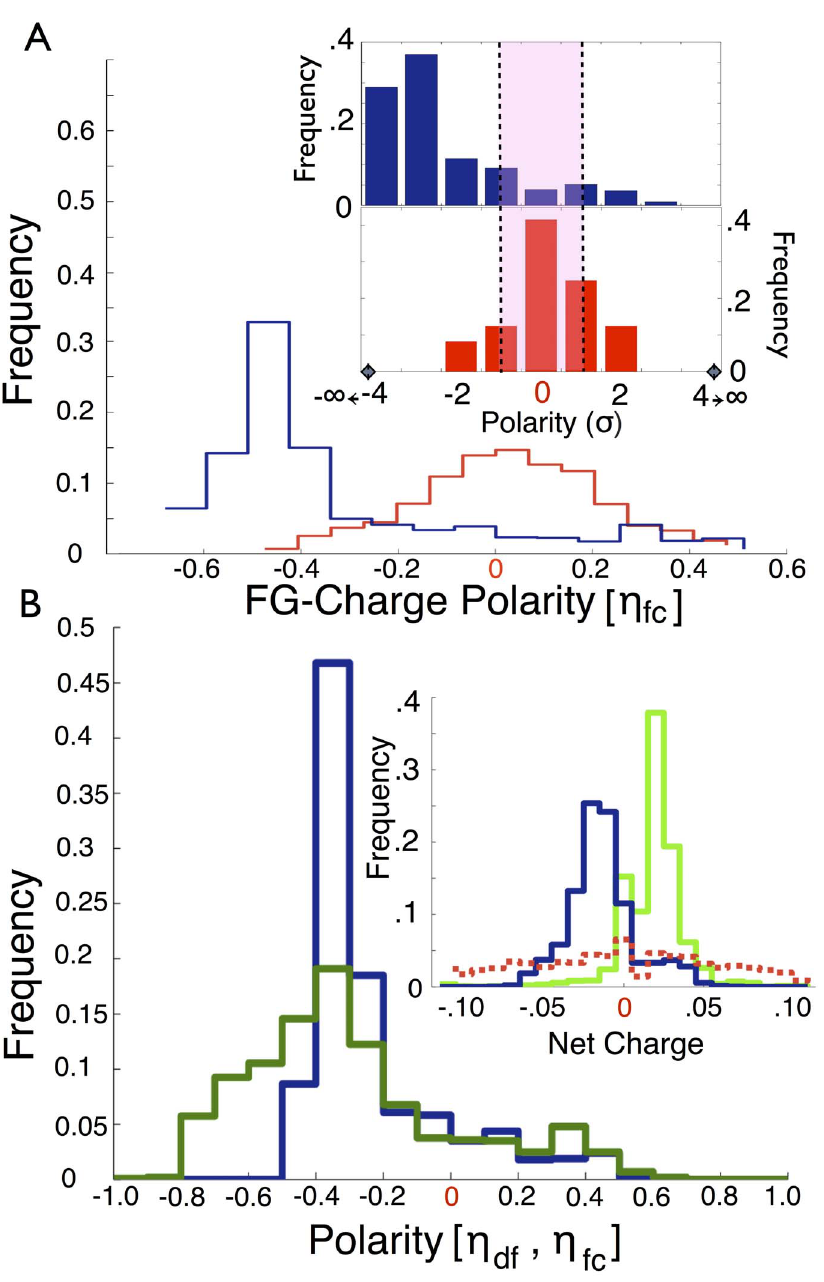
Figure 2. Polarity and charges of FG nups. (A) Polarity g fc between charge and FG regions. FG nups (blue) tend to adopt a large negative and well conserved value for N-terminus to C-terminus polarity. Randomly shuffled FG nups showed no overall average polarity (red) and the statistical significance of FG nup polarity was consistently higher than three standard deviations (inset, blue, upper). The control group did not show a considerable difference from the random ensemble (inset, red, lower). (B) Polarity g df between disordered and folded regions (blue) using the PONDR [22] protein disorder predictor. Observed polarities are on average similar to FG to charge cluster polarities, g fc . Interestingly, g fc values for the disordered regions alone (green) show a similar trend. Inset shows the net charge of folded structural nups/kaps (blue) and FG clusters (green) which appear to be equal and opposite on the whole, while disordered charge cluster regions (red dashed) appear to be net neutral. Histogram values for net charges for charge clusters greater than 0.1 e/AA and less than 2 0.1 e/AA are negligible and are shown in Text S1.